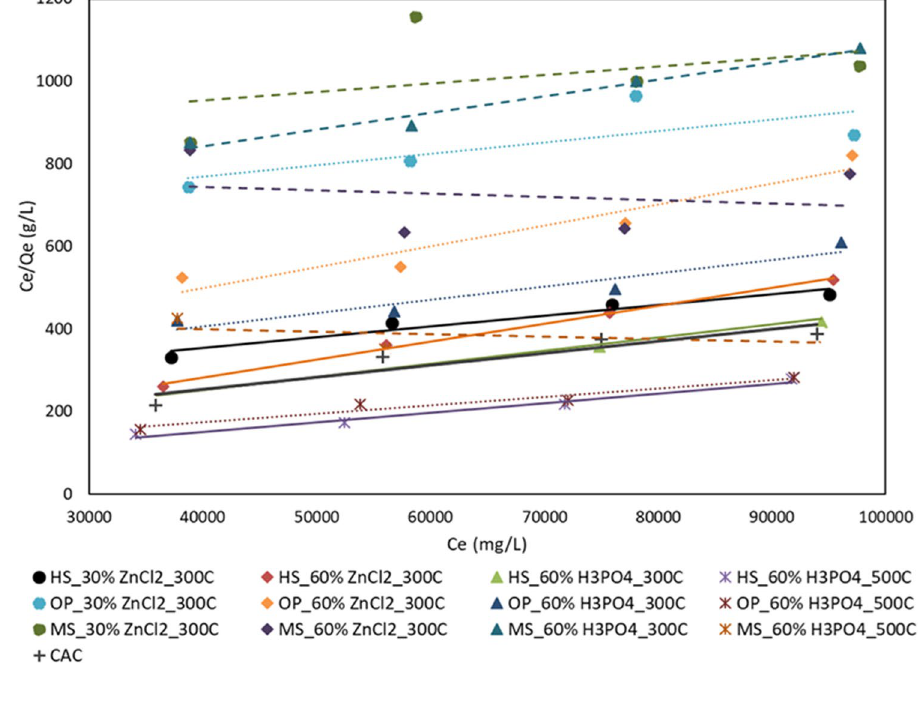
Fig. 4 Freundlich isotherms of acetic acid adsorptions onto three activated carbons after four different activation